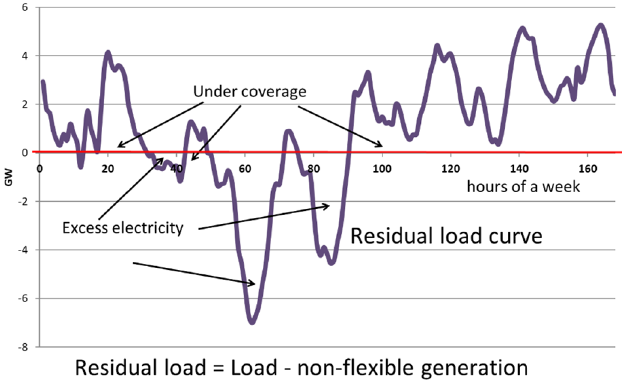
Fig. 9. The residual load curve referring to Figure 8 representing the difference between total load and the aggregate of